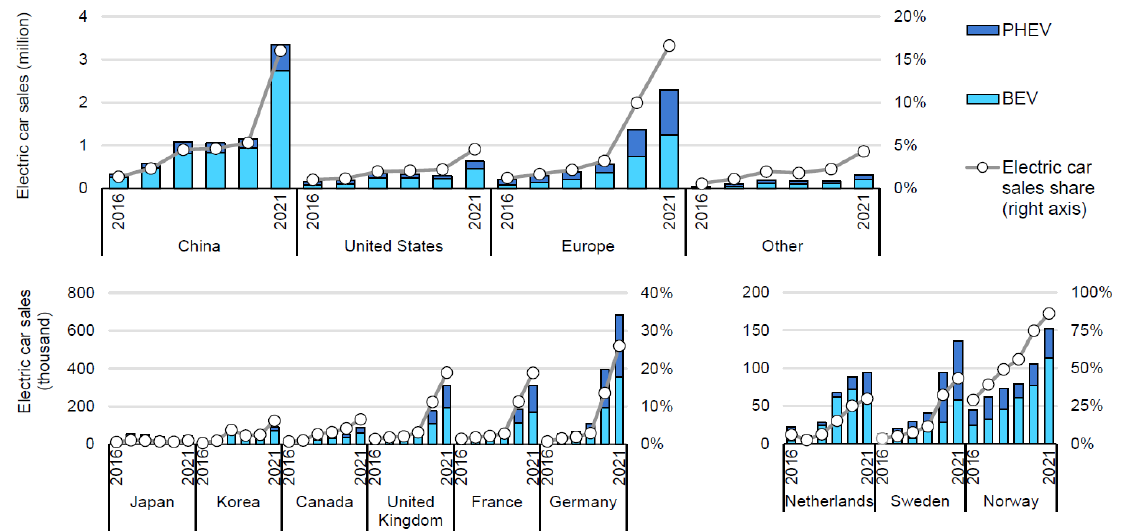
Figure 2. EV sales and market share worldwide from 2016 to 2021.